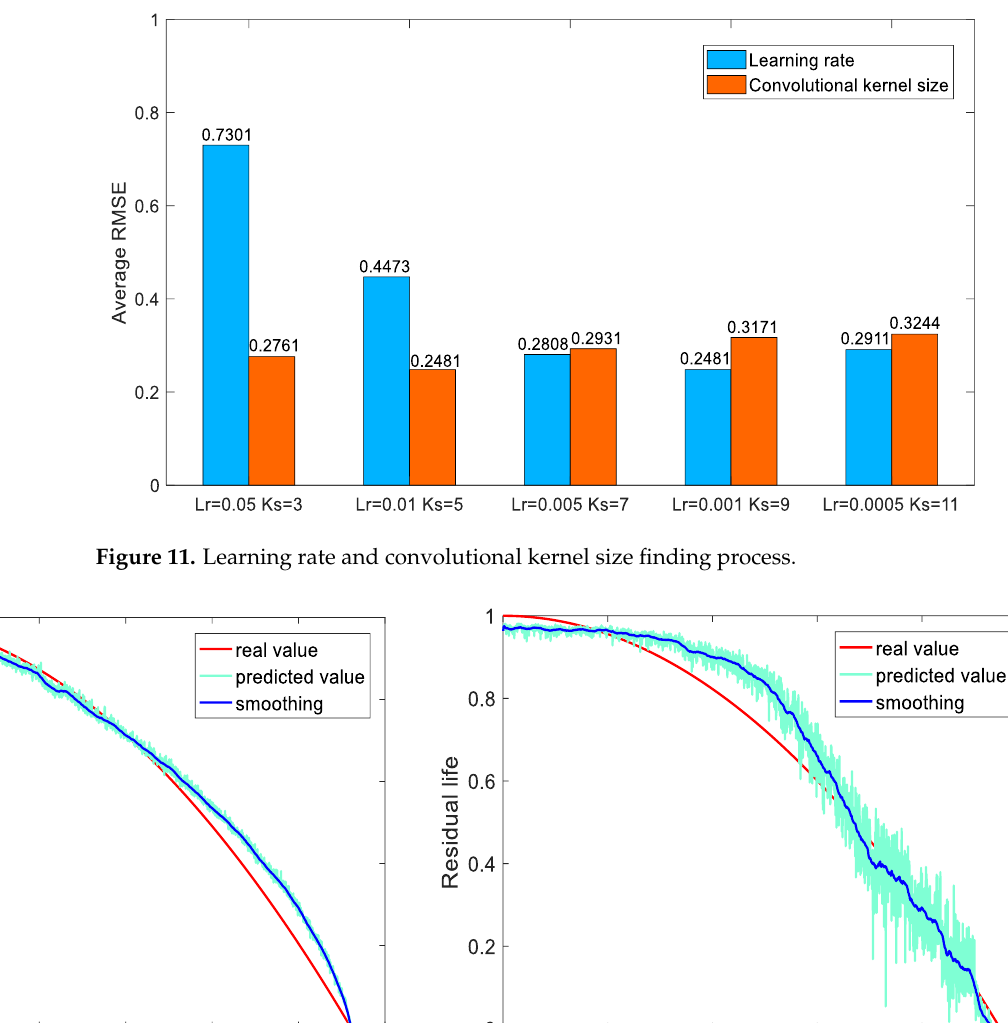
Figure 13. RUL prediction results of each method on test bearing 1 − 3.